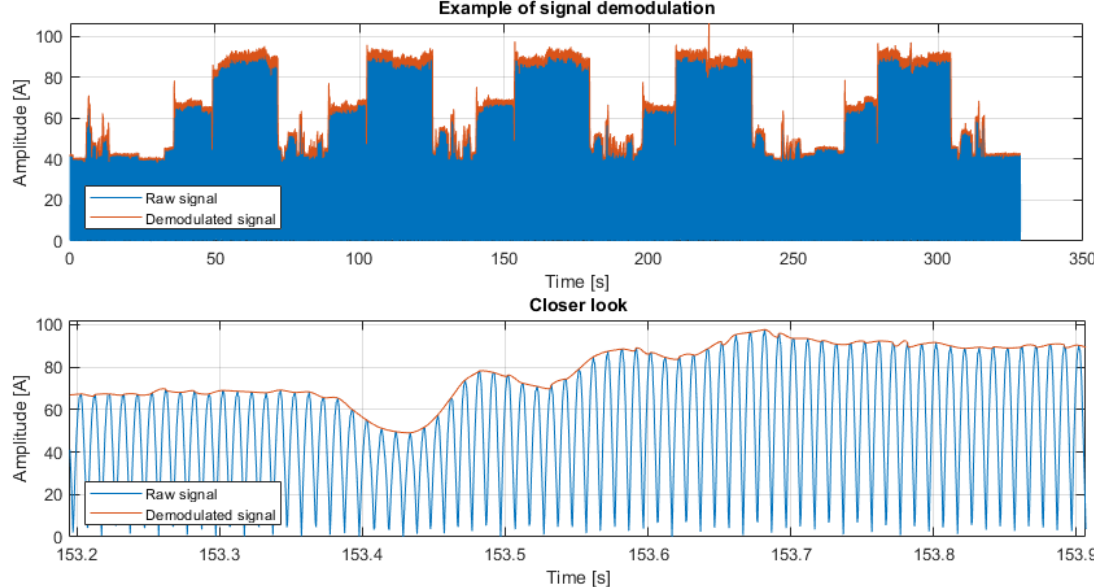
Figure 10. Raw data output from the current clamp sensor (blue), amplitude-demodulated to obtain proper values of the current (red).